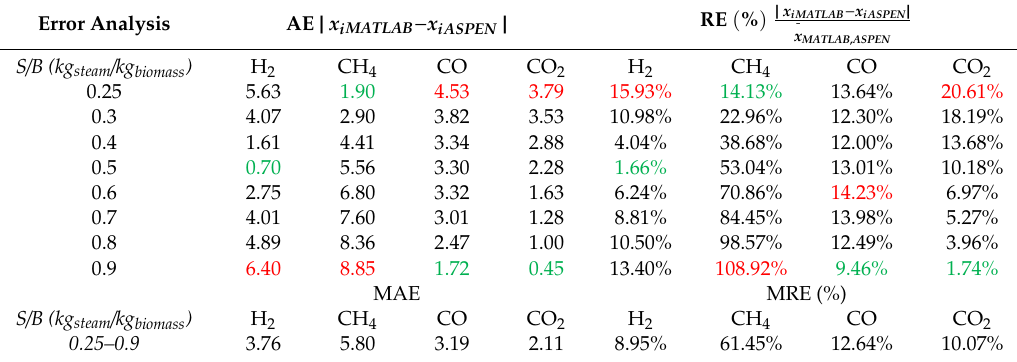
Table 7. Absolute error (AE) and Relative Error (RE) between the Aspen Plus and MATLAB model for each S / B operating point. Maximum values (red), minimum values (green). Mean Absolute Error (MAE) and Mean Relative Error (MRE) over the whole range of S /